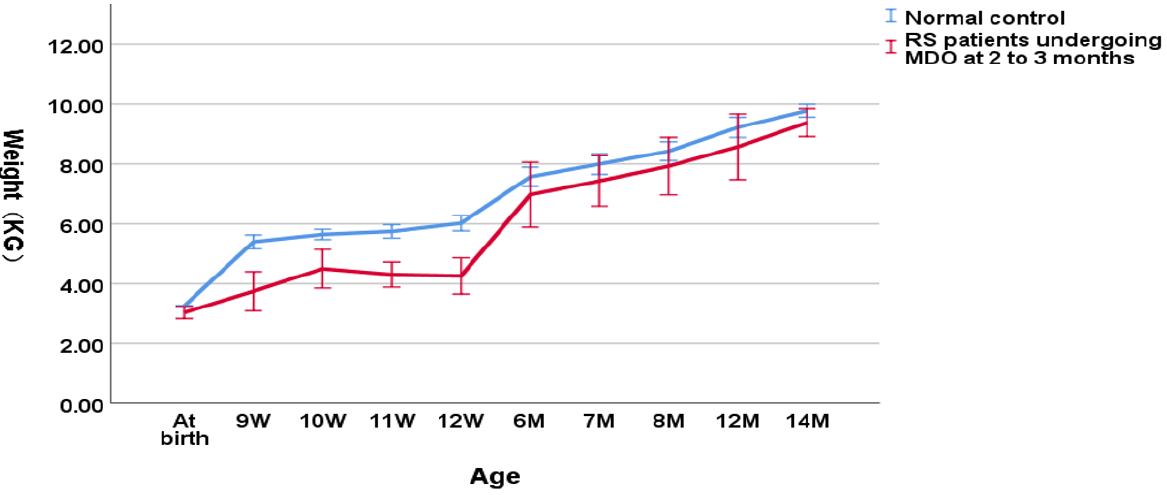
Figure 2. Wight-for-age chart (RS patients undergoing MDO at 1 to 2 months versus normal control). As shown in Figure 3, in the group undergoing MDO at 2 to 3 months, the weight of RS patients was also significantly lower compared to the normal controls (4.12 ± 0.81 kg versus 5.88 ± 0.33 kg, p < 0.001 for the weight at the timing point of MDO and 4.43 ± 0.79 kg versus 6.26 ± 0.46 kg, p < 0.001 for the post-discharge weight). However, at the timing point of distractor removal, the weight of RS patients could not reach a normal weight compared to the normal controls (7.56 ± 1.29 kg versus 8.20 ± 0.61 kg, p = 0.000206). At aged one year, RS patients finally reached the normal weight compared to the normal controls (9.38 ± 0.29 kg versus 9.83 ± 0.53 kg, p = 0.098).